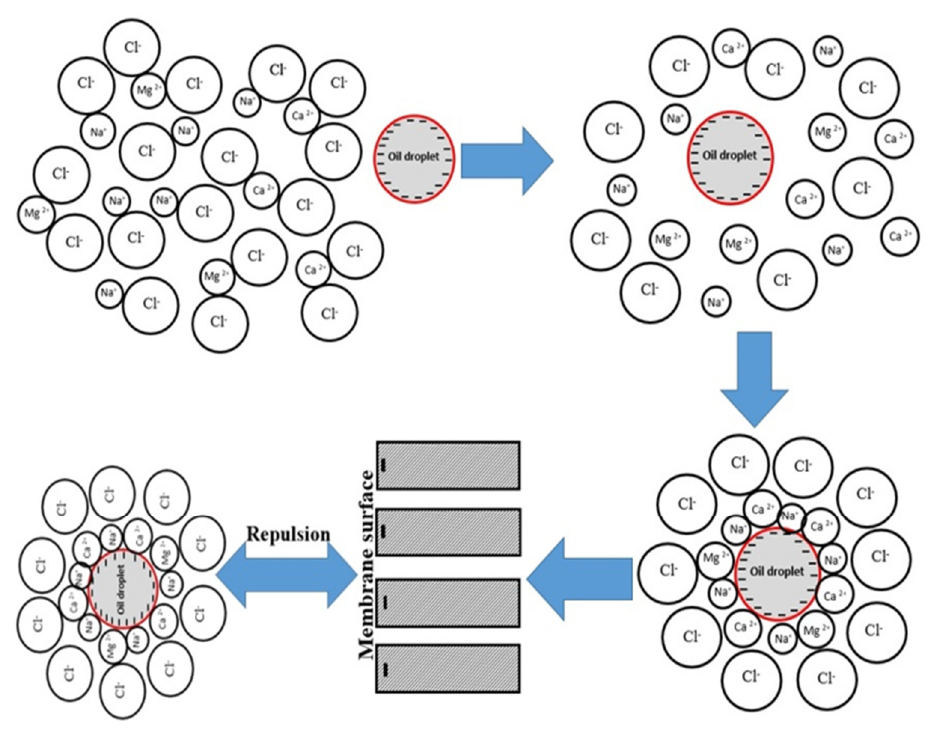
Figure 10. Schematic representation of effect of ionic strength and membrane surface charge on oil and salt rejection.